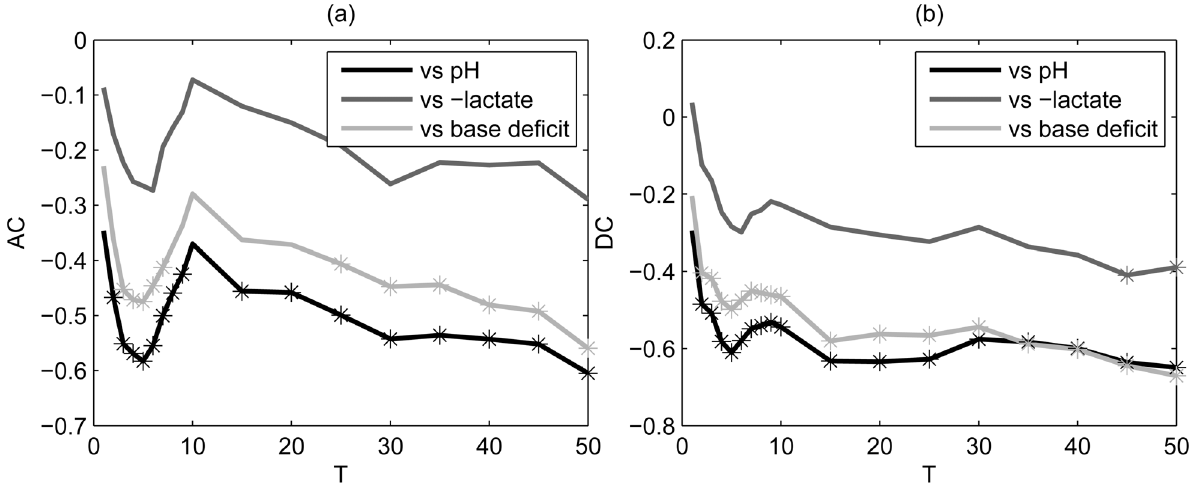
Figure 6. Spearman’s correlation coefficients between AC (a) and DC (b) and each acid-base balance biomarker. PRSA was performed on stable (concatenated baseline and free of FHR decelerations) baseline fRR intervals. Stars refer to significant p values (p , 0.05). Lactate values were multiplied by 2 1.